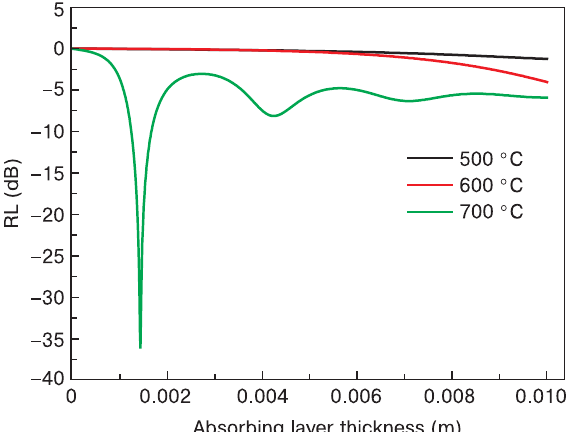
Figure 6. Optimization of absorbing layer thickness.